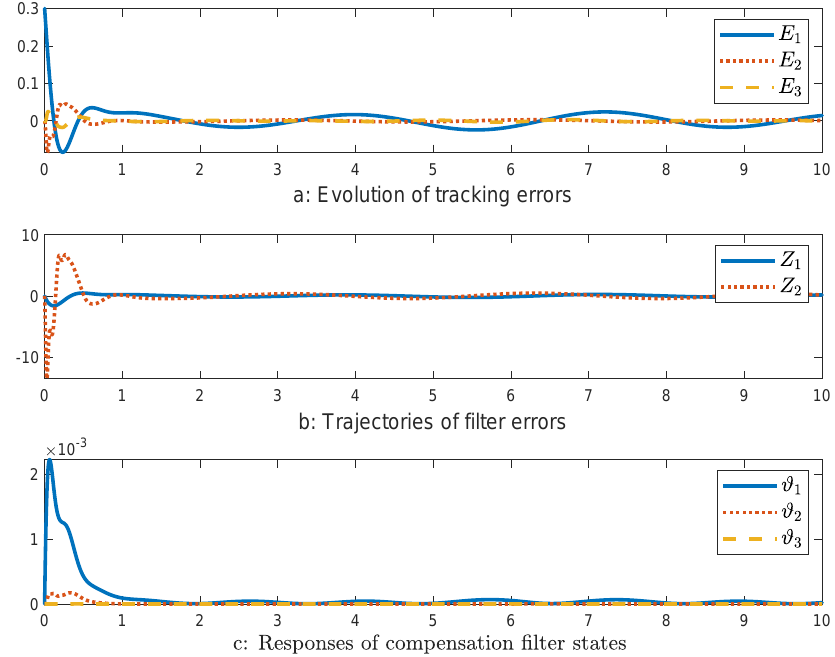
Figure 8. Curves of error signals and compensation filter states.